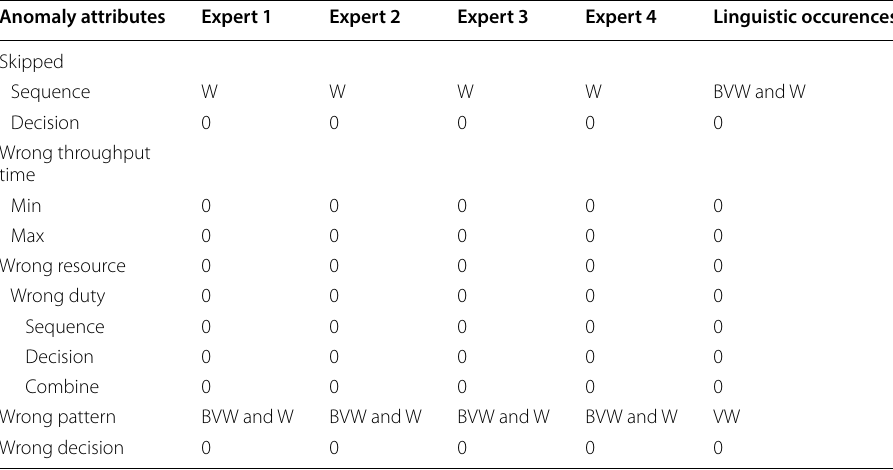
Table 6 Assesment of occurrences for a case Anomaly attributes